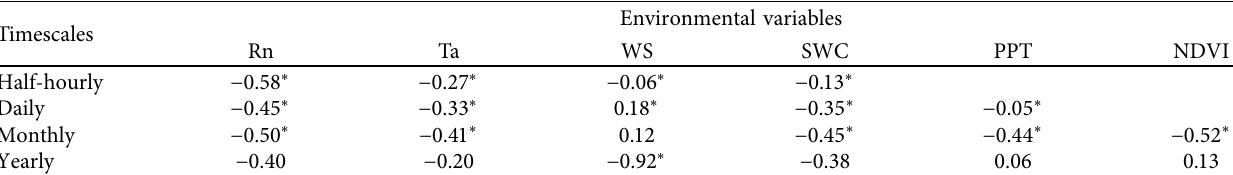
Figure 10: Cumulative net CO 2 ecosystem exchange (NEE) for each year during 2007 to 2018. Table 6: Similar to Table 4, the fux variable is the CO 2 fux (Fc), and the environmental variables include Rn, Ta, WS, PPT, NDVI, and soil water content (SWC). Te Fc is the average value from half-hourly to monthly timescales, and the annual Fc is the annual total value.